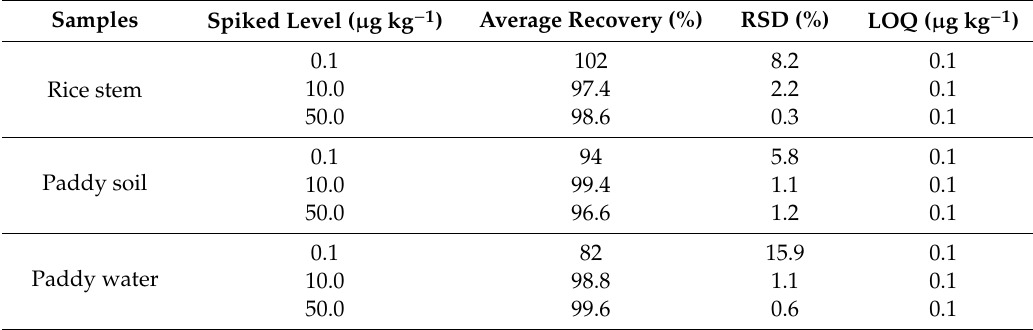
Table 2. Recovery and relative standard deviations (RSDs) ( n = 5) of emamectin benzoate at the spiked level in blank